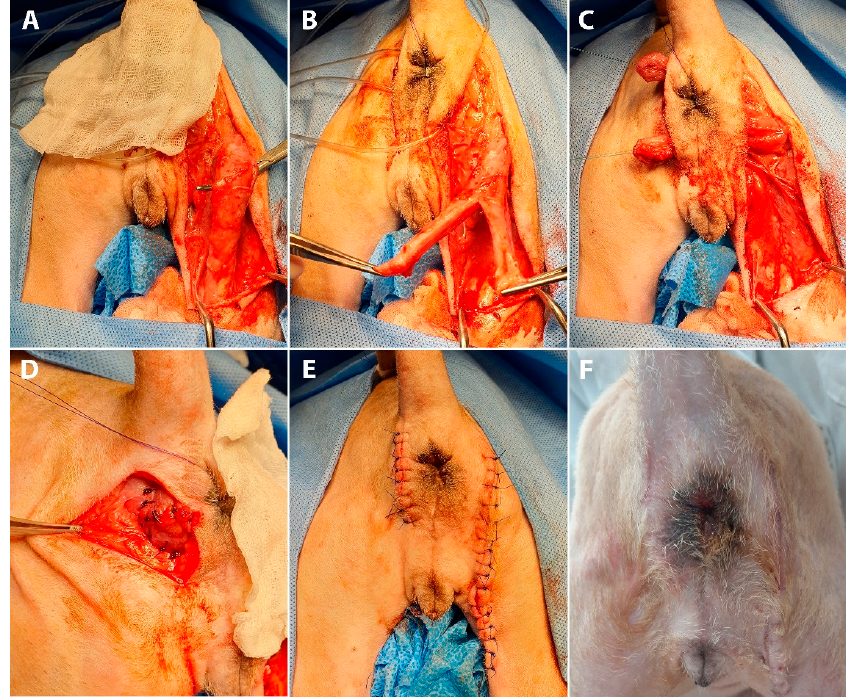
Figure 2. Intraoperative ( A – E ) and postoperative ( F ) views of bifurcated semitendinosus muscle flap transposition in a dog with anal sphincter incompetence. ( A ) The semitendinosus is carefully dissected to minimize damage to the blood and nerve supply to the proximal part. ( B ) After the semitendinosus muscle is transected at the level between the middle and distal one-third, the distal half is divided into two bundles by longitudinally cutting the middle part of the muscle body. ( C ) Two bundles are passed through the tunnels created at the dorsal and ventral sides of the anus. ( D ) The semitendinosus muscle bundles are sutured to the adjacent rectal muscle and the pelvic diaphragm, and crotch sutures are placed between two muscle bundle ends to narrow the anorectal lumen. ( E ) After surgery, the anus was successfully narrowed without exposed mucosa. ( F ) At the three-month postoperative follow-up, the morphology of the anal orifice is